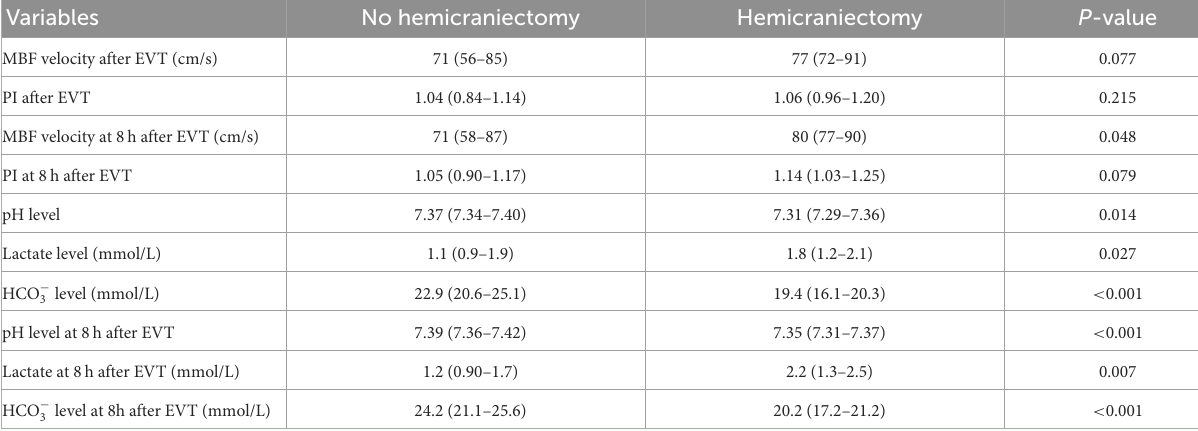
TABLE 4 Comparison between favorable and poor prognosis according to the outcome: Hemicraniectomy performed during